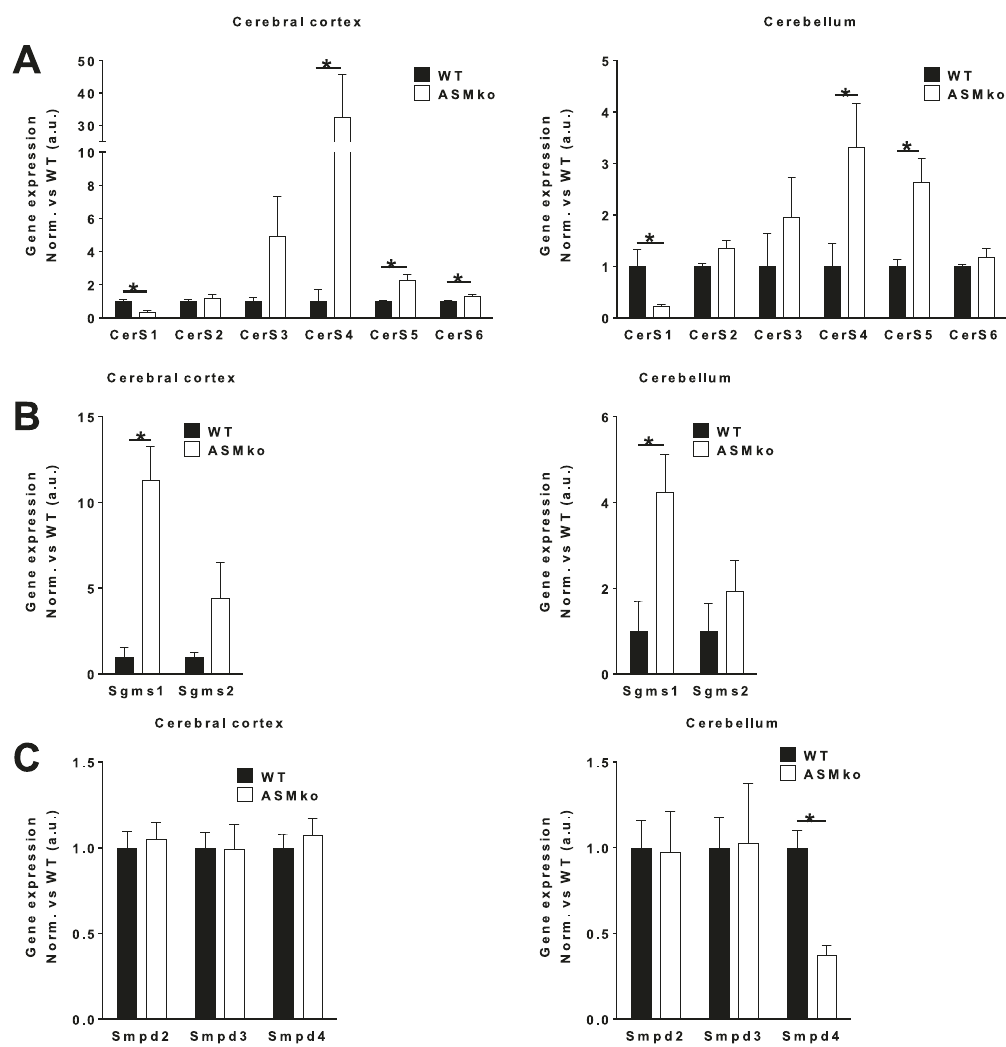
Fig. 4 Altered gene expression of SM metabolic enzymes in the brain of ASMko mice. A Graphs show mean ± SEM expression levels of CerS1-6 genes encoding for CerS1-6 measured by qPCR in cortical or cerebellar extracts of wt and ASMko mice. Data are expressed in arbitrary units normalized to the values obtained in wt mice that were considered 1 ( n = 5; * p < 0.05). B Graphs show mean ± SEM expression levels of the Sgms1-2 genes encoding for SMS1-2, measured by qPCR in cortical and cerebellar extracts of wt and ASMko mice. Data are expressed in arbitrary units normalized to the values obtained in wt mice that were considered 1 ( n = 5; * p < 0.05). C Graphs show mean ± SEM expression levels of the Smpd2-4 genes encoding for Smases2-4, measured by qPCR in cortical and cerebellar extracts of wt and ASMko mice. Data are expressed in arbitrary units normalized to the values obtained in wt mice that were considered 1. ( n = 5; * p <